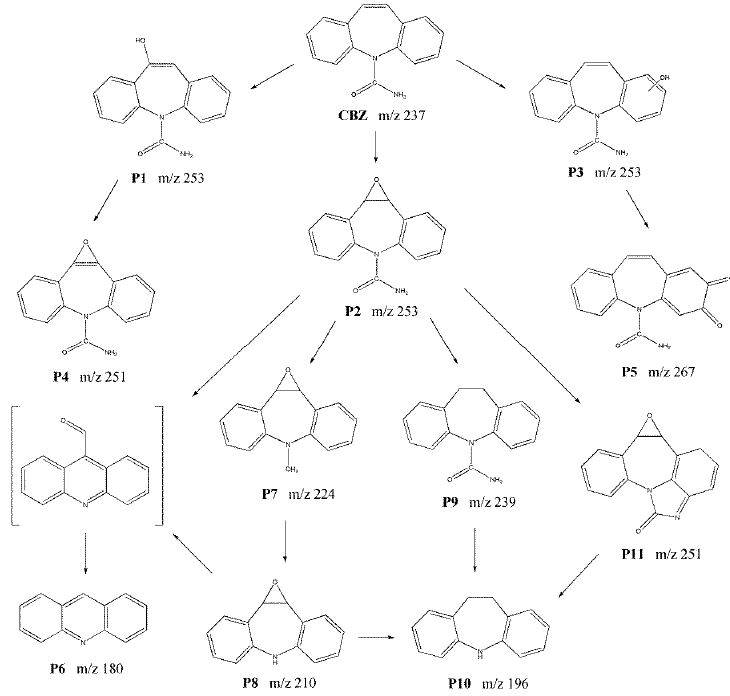
Figure 12. Tentative degradation pathway of CBZ.